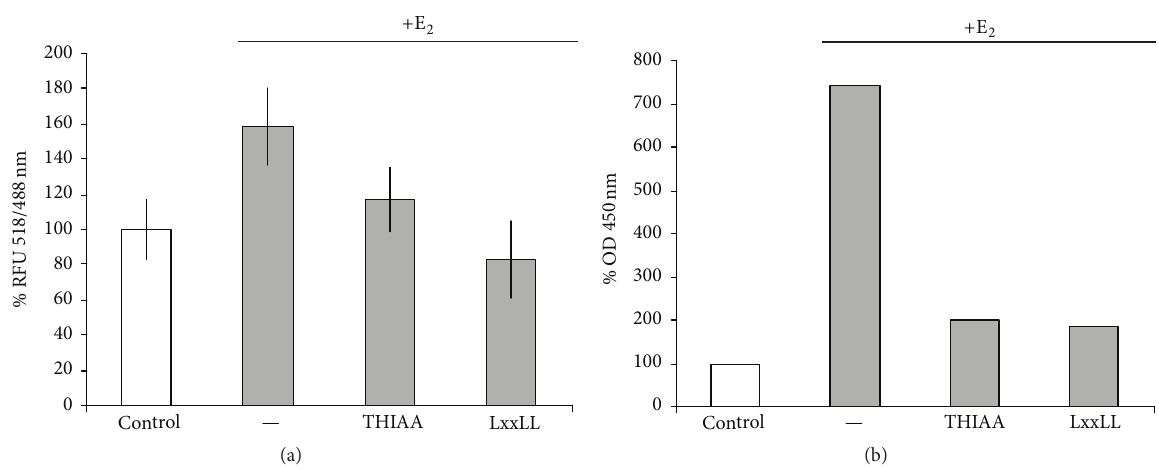
Figure 11: Effect of THIAA on LxxLL motif recruitment assessed by TR-FRET (a) and ELISA (b). For TR-FRET experiments, recombinant ER 𝛼 was incubated in the absence (control) or presence of E 2 at 10 −6 M with or without THIAA at 0.001% or an LxxLL competitor peptide at 10 −4 M. Fluorescence emission was measured at 488 nm and 518nm under a 332 nm excitation wavelength. Data refer to the mean value ± SD of Relative Fluorescence Unit (RLU) ratio at 518 nm and 488 nm of an experiment performed twice in triplicate. For ELISA, cell extracts of MCF-7 treated or not with E 2 at 10 −9 M (30 min) were incubated with or without THIAA at 0.001% or an LxxLL competitor peptide at 10 −4 M. Cell extracts where then submitted to this ELISA in which the capture element is an LxxLL peptide. Data refer to an experiment performed three